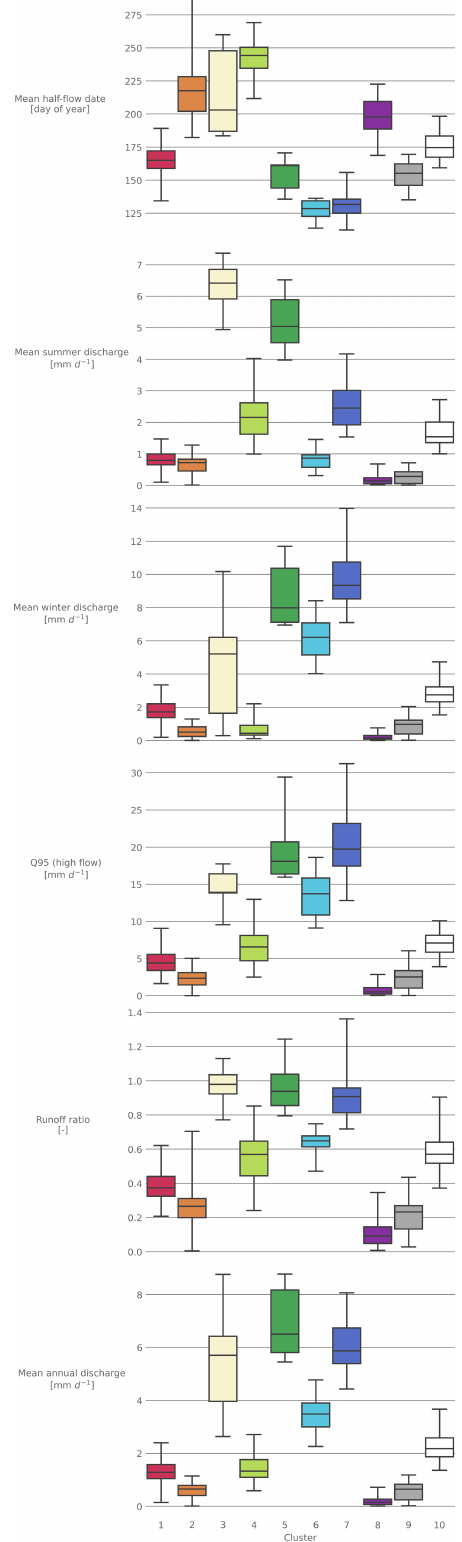
Figure 7. Boxplots of the catchment attributes of the clusters. Figure 8. Boxplots of the hydrological signatures of the